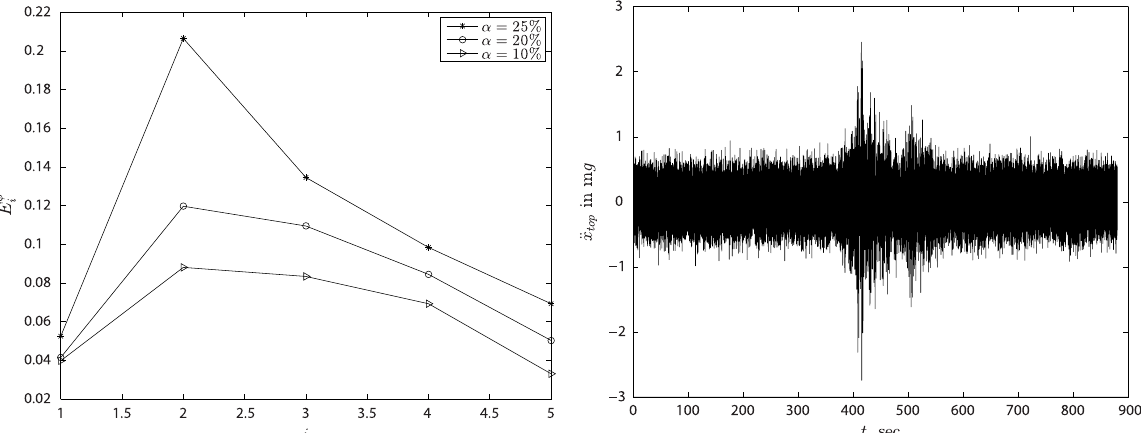
Fig. 12. Variation in RMS error in the mode shape coordinates at dif- ferent floor levels.